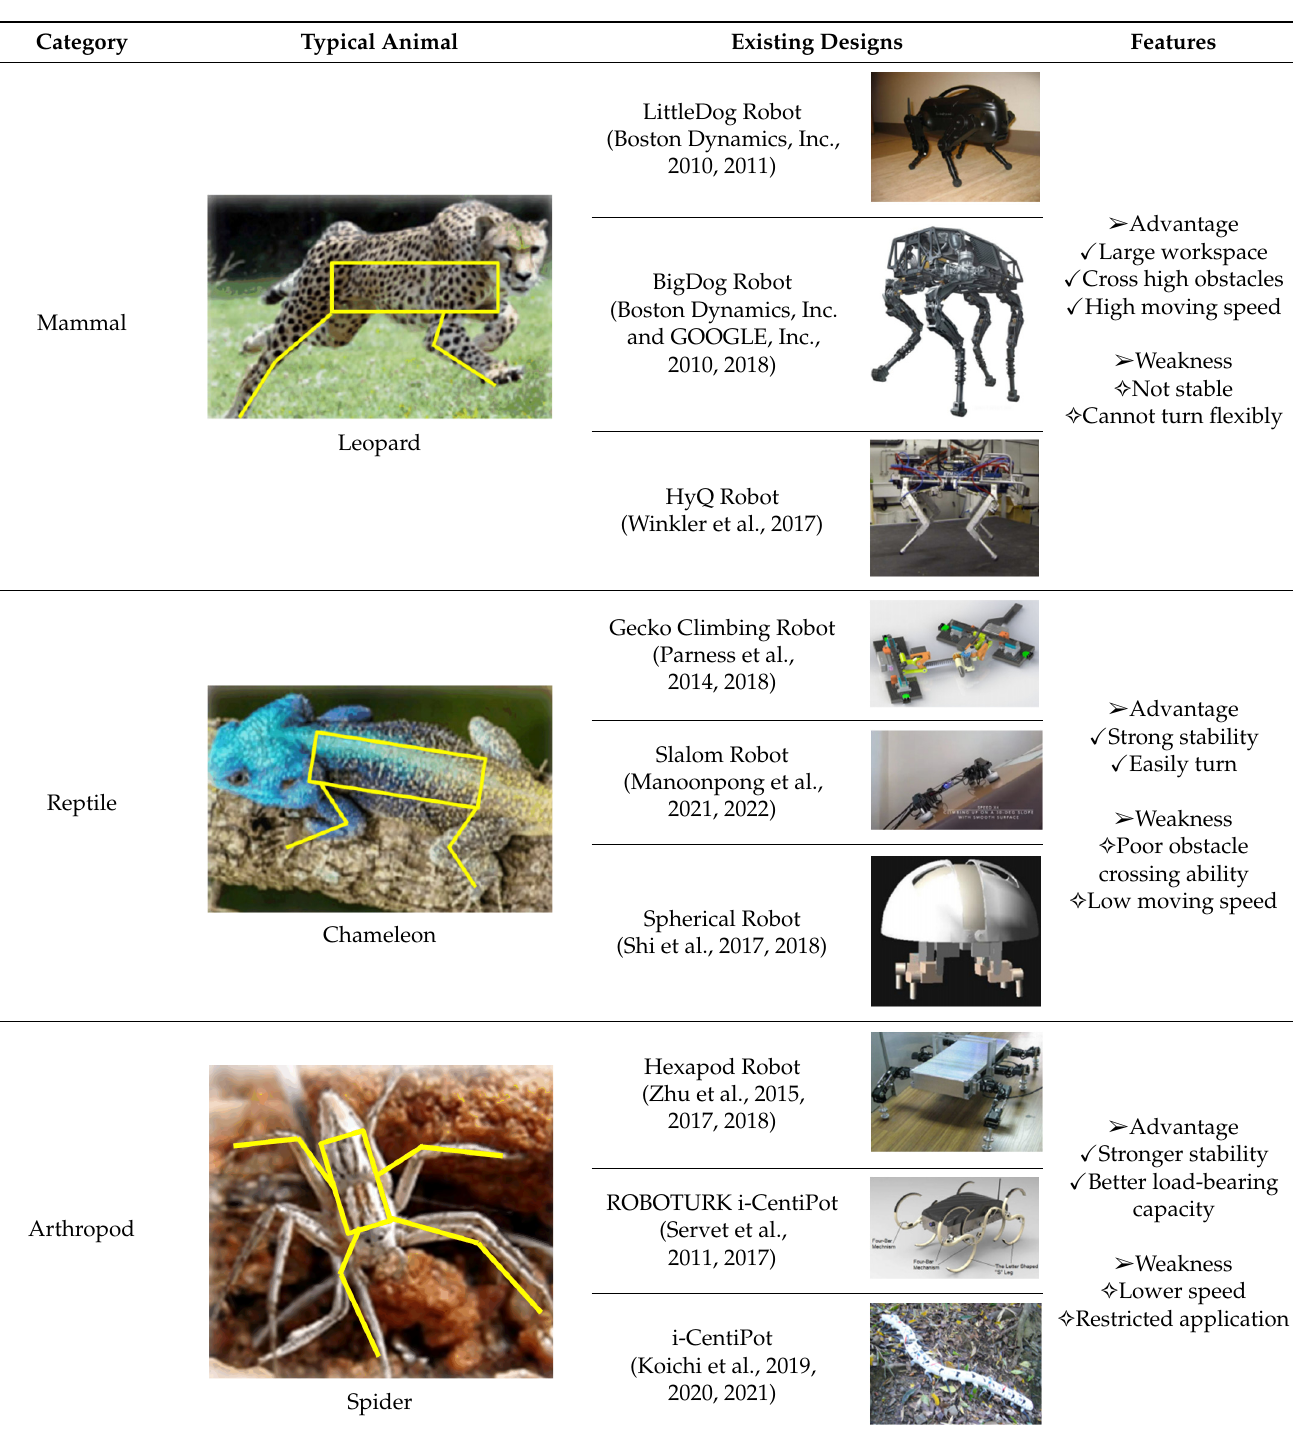
Table 1. Summary of legged robots.